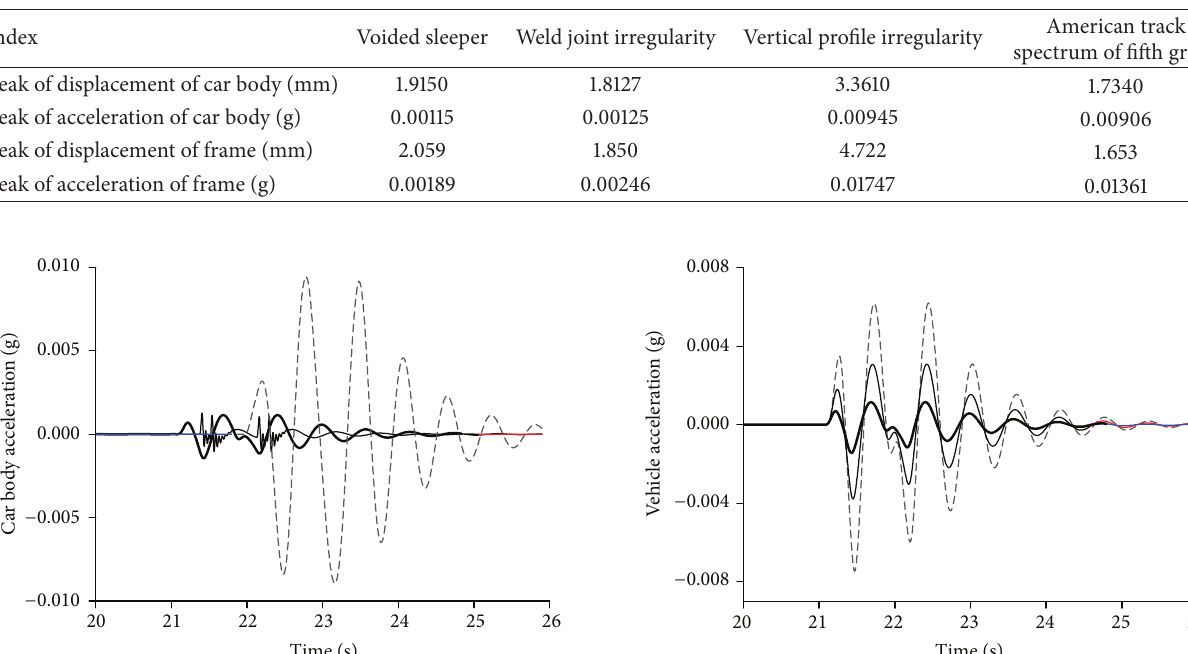
Table 1: Comparison of vibration responses of vehicle system.